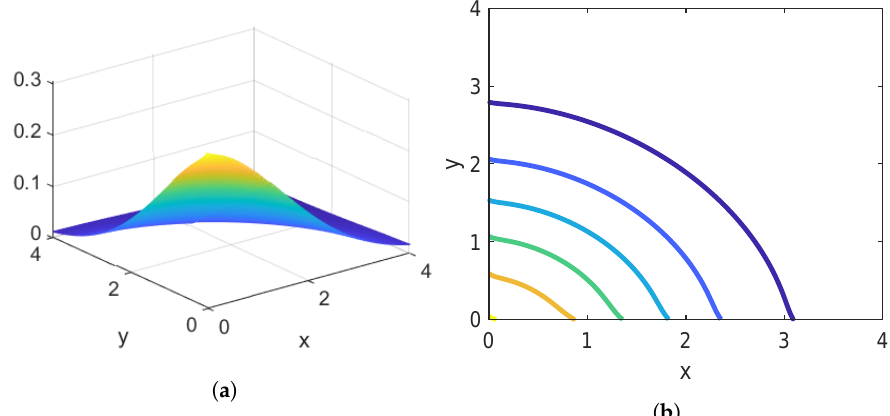
Figure 8. Joint distribution of M τ and D τ . The joint density is in the left panel and a contour plot in the right.